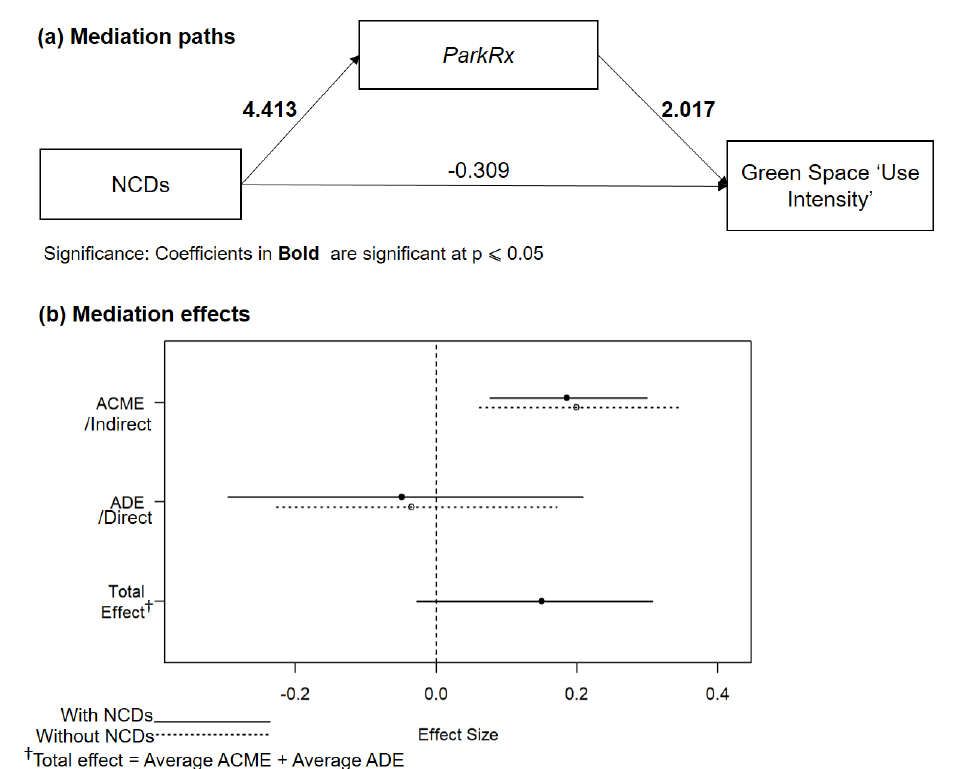
Figure 3. ( a ) ParkRx as a mediator of the NCDs and use intensity association. ( b ) Average causal mediation (ACME), average direct effect (ADE) for both NCDs and non-NCDs groups, and the total effect of NCDs and ParkRx on ‘Use intensity’. Table 6. Mediation analyses of NCDs and mediator ParkRx on use intensity.